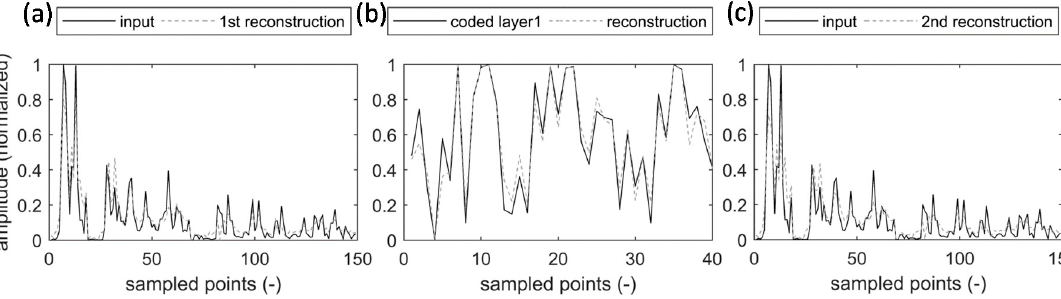
Figure 11. The input and output patterns of autoencoders: ( a ) the first autoencoder; ( b ) the second autoencoder; ( c ) reconstruction of the original input patterns after two layers of encoding and decoding.